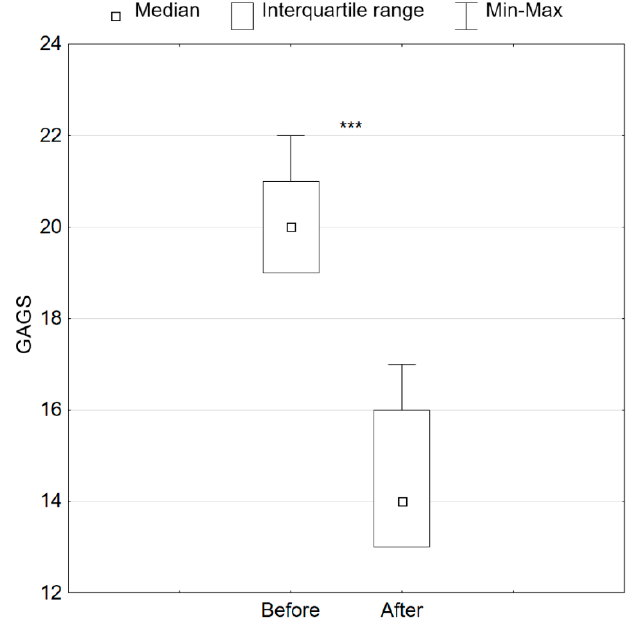
Figure 1. Advancement of acne according to GAGS before and after treatments, *** p < 0.001.